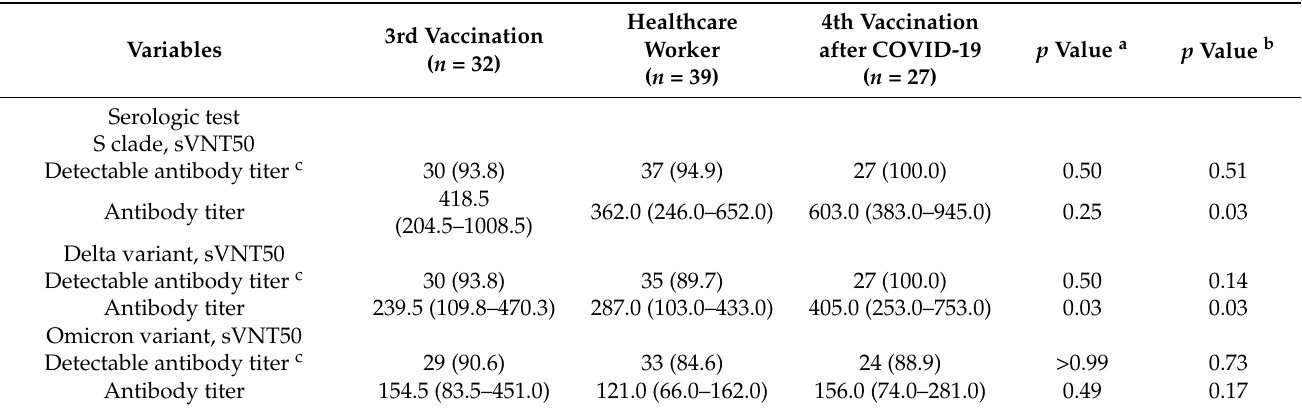
Table 3. Comparison of serologic results in each cohort that did or did not receive subsequent 4th vaccination and with history of 3rd vaccination before SARS-CoV-2